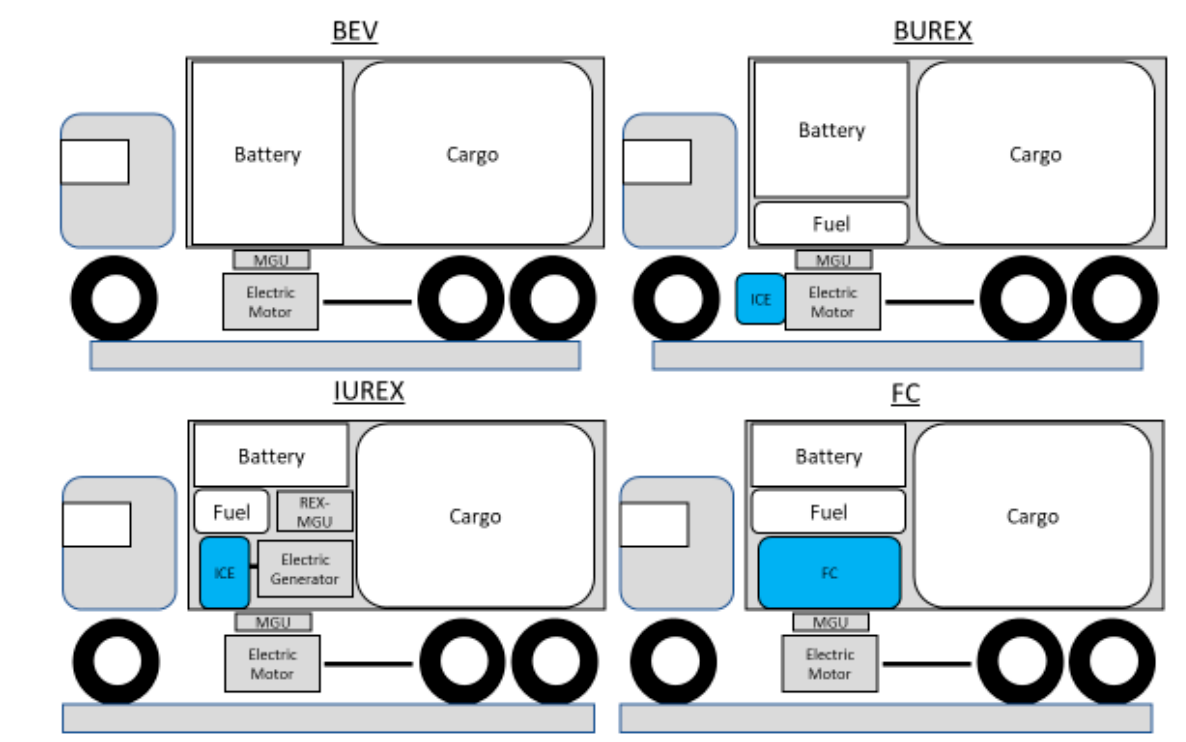
Figure 1. A pure HD BEV and BEVs with different range-extending support